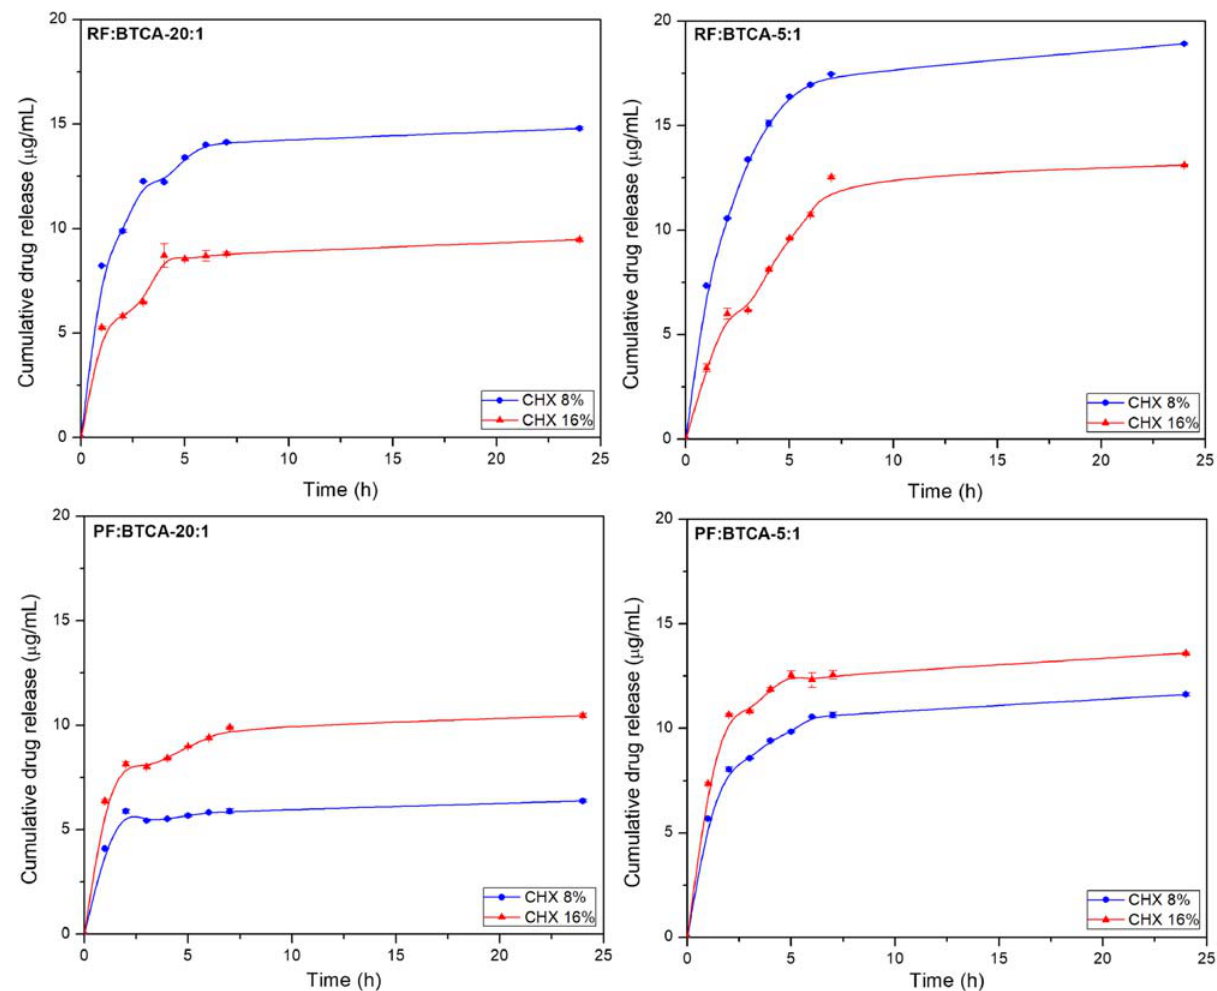
Figure 6: Cumulative release of chlorhexidine from Ceiba pentandra ’ s fi bers. Raw fi bers ( top ) , pretreated fi ber ( bottom )